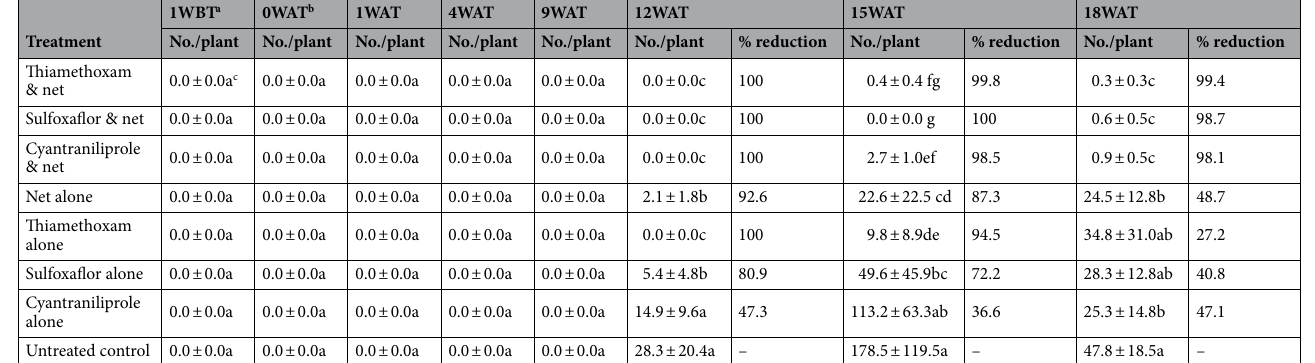
Table 3. Effects of different treatments on Bemisa tabaci egg populations during the whole growing season (greenhouse trial I, 2018). a WBT, weeks before transplanting; 1 WBT is the time of root drenching. b WAT, weeks after transplanting; 0 WAT is the time of seedling transplanting; 12 WAT is the time of first fruit harvest; 18 WAT is the end of the greenhouse trials. c In the columns, the data are the means ± SD of four replications, with 10 plants per replicate. Means followed by the same letter are not significantly different at P = 0.05 level according to the LSD test.